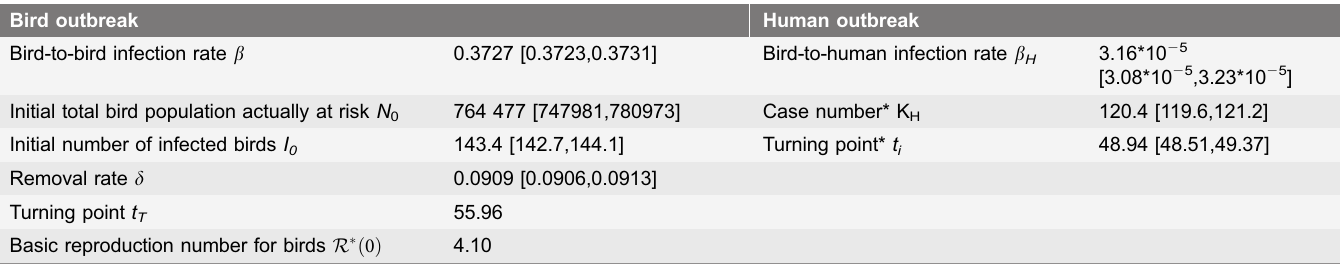
Table 1. Estimated model parameter values with 95% CIs (in brackets) via the bird-human epidemic model (Equations (4) and (21)) and the Richards model using H7N9 human case data by onset date in China, February 19––May 30,